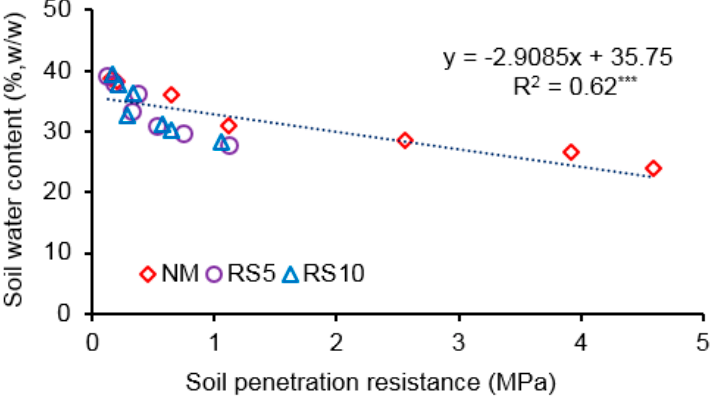
Figure 5. Relationship between average soil water content and average soil resistance (0–30 cm soil depth) from sowing to bud formation. NM = no-mulch; RS5 = rice straw at ~5 t ha − 1 ; RS10 = rice straw at ~10 t ha − 1 . *** indicates significance at 0.1% probability level.